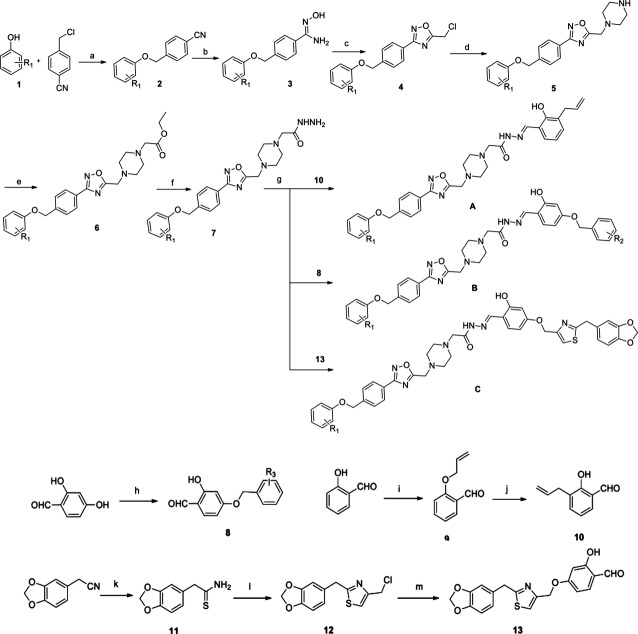
SchemeThe preparation of the target compounds.